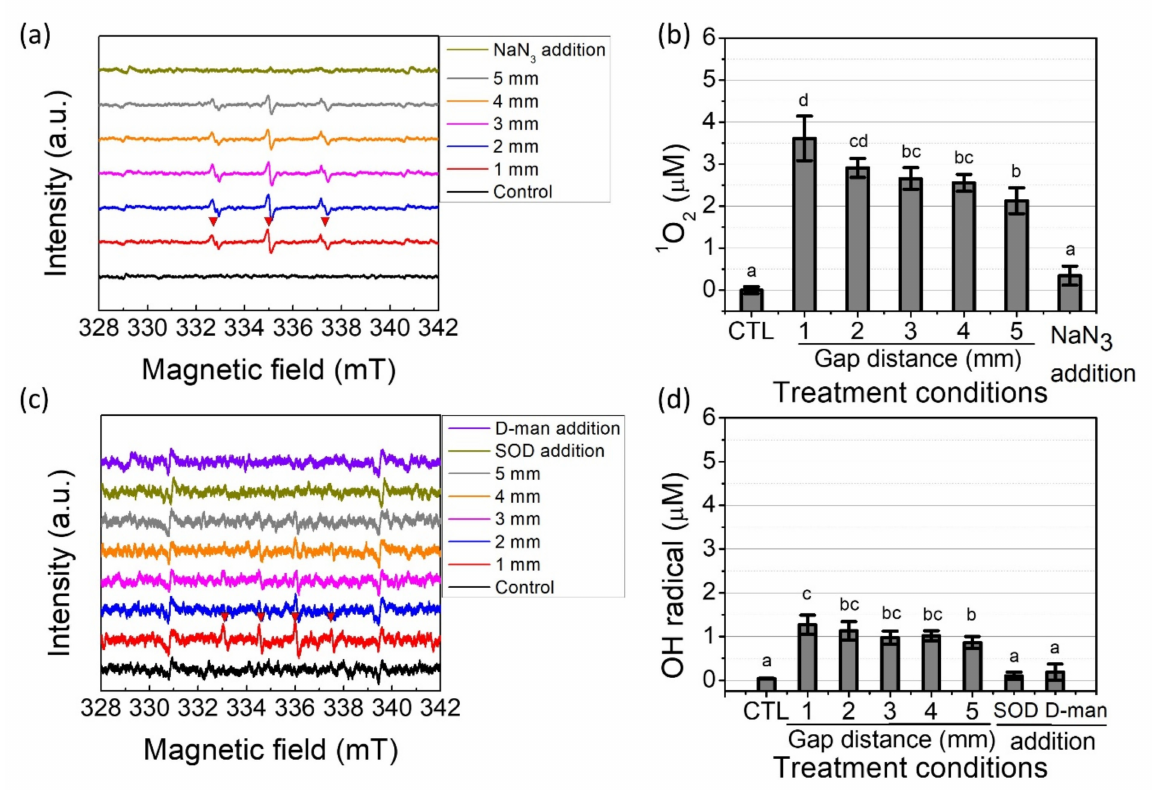
Figure 4. Electron spin resonance signals and concentration from pin-to-water plasma treatment ( a ) TEMPO (spin adduct of 1 O 2 ); ( b ) concentration of 1 O 2 ; ( c ) DMPO-OH (spin adduct of OH • ); ( d ) concentration of OH • . The treatment time was kept at 20 s. Results are presented as the mean ± standard deviation from three independent experiments. Different letters indicate significant differences ( p <